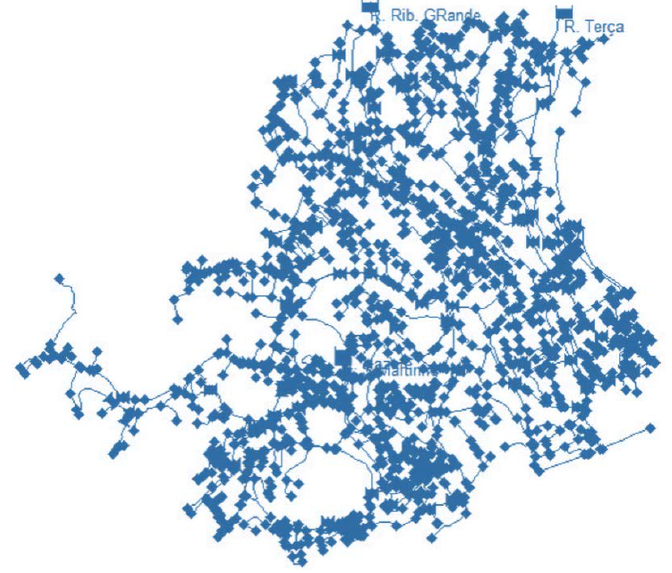
Figure 11. Funchal network layout.